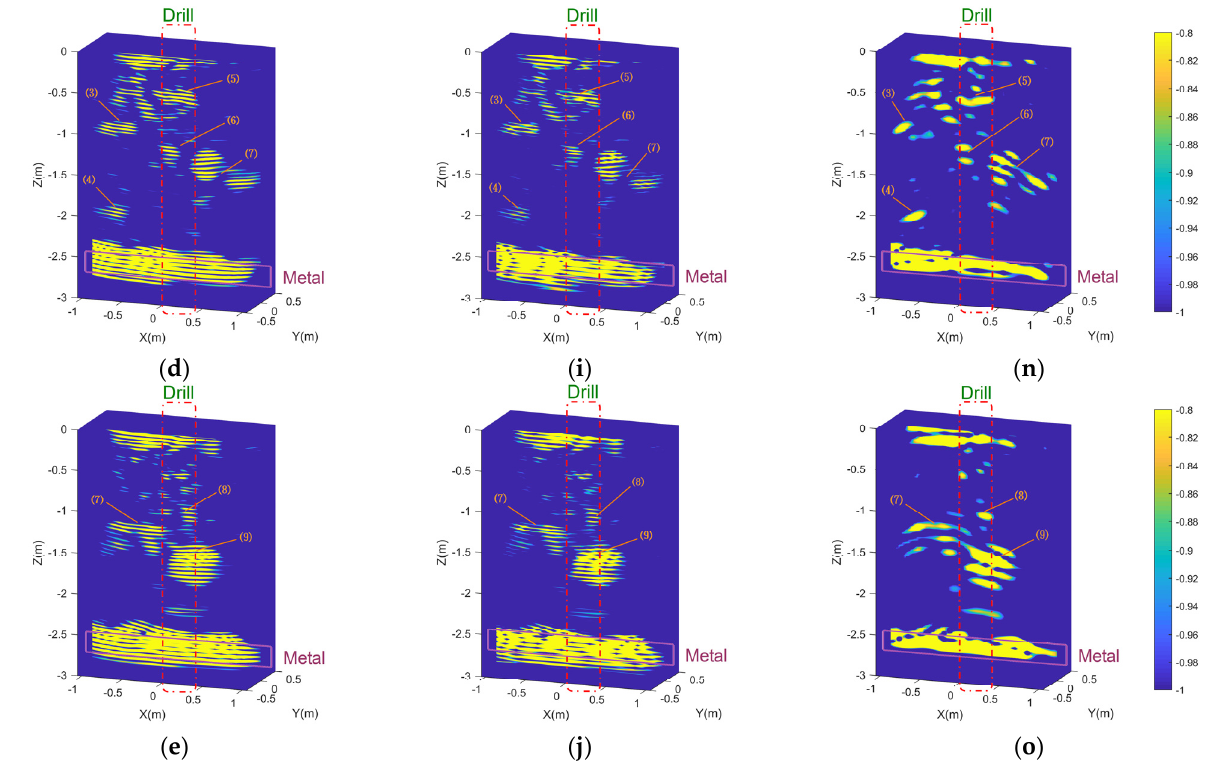
Figure 9. RTM imaging from the CE-5 measured data in different time-domain methods: ( a – e ): C-FDTD-RTM; ( f – j ): HO-FDTD-RTM; ( k – o ) PSTD-RTM.